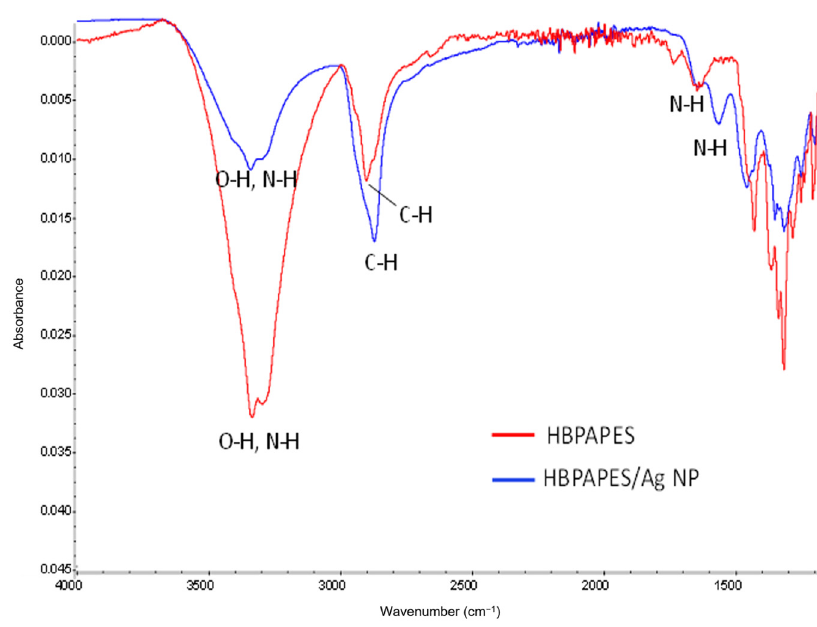
Figure 4. FTIR spectra of pure HBPAPES and HBPAPES with encapsulated Ag NPs.